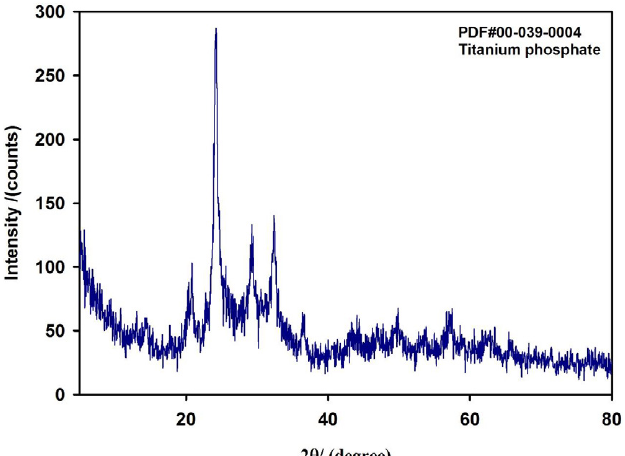
Fig.2. XRD pattern of TiP